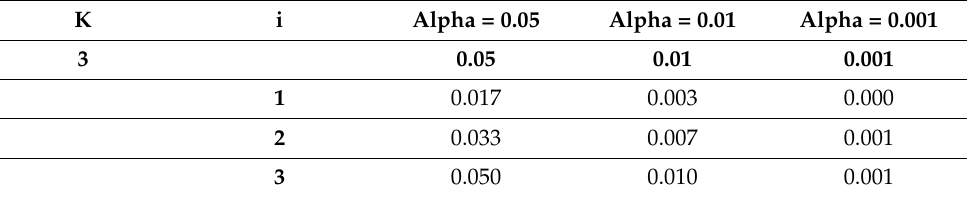
Table 5. Benjamini-Hochberg correction for multiple comparisons: Comparison of microRNA gene expression between preterm and normal term pregnancies (PTB vs. PPROM vs. normal pregnancies). K i Alpha =